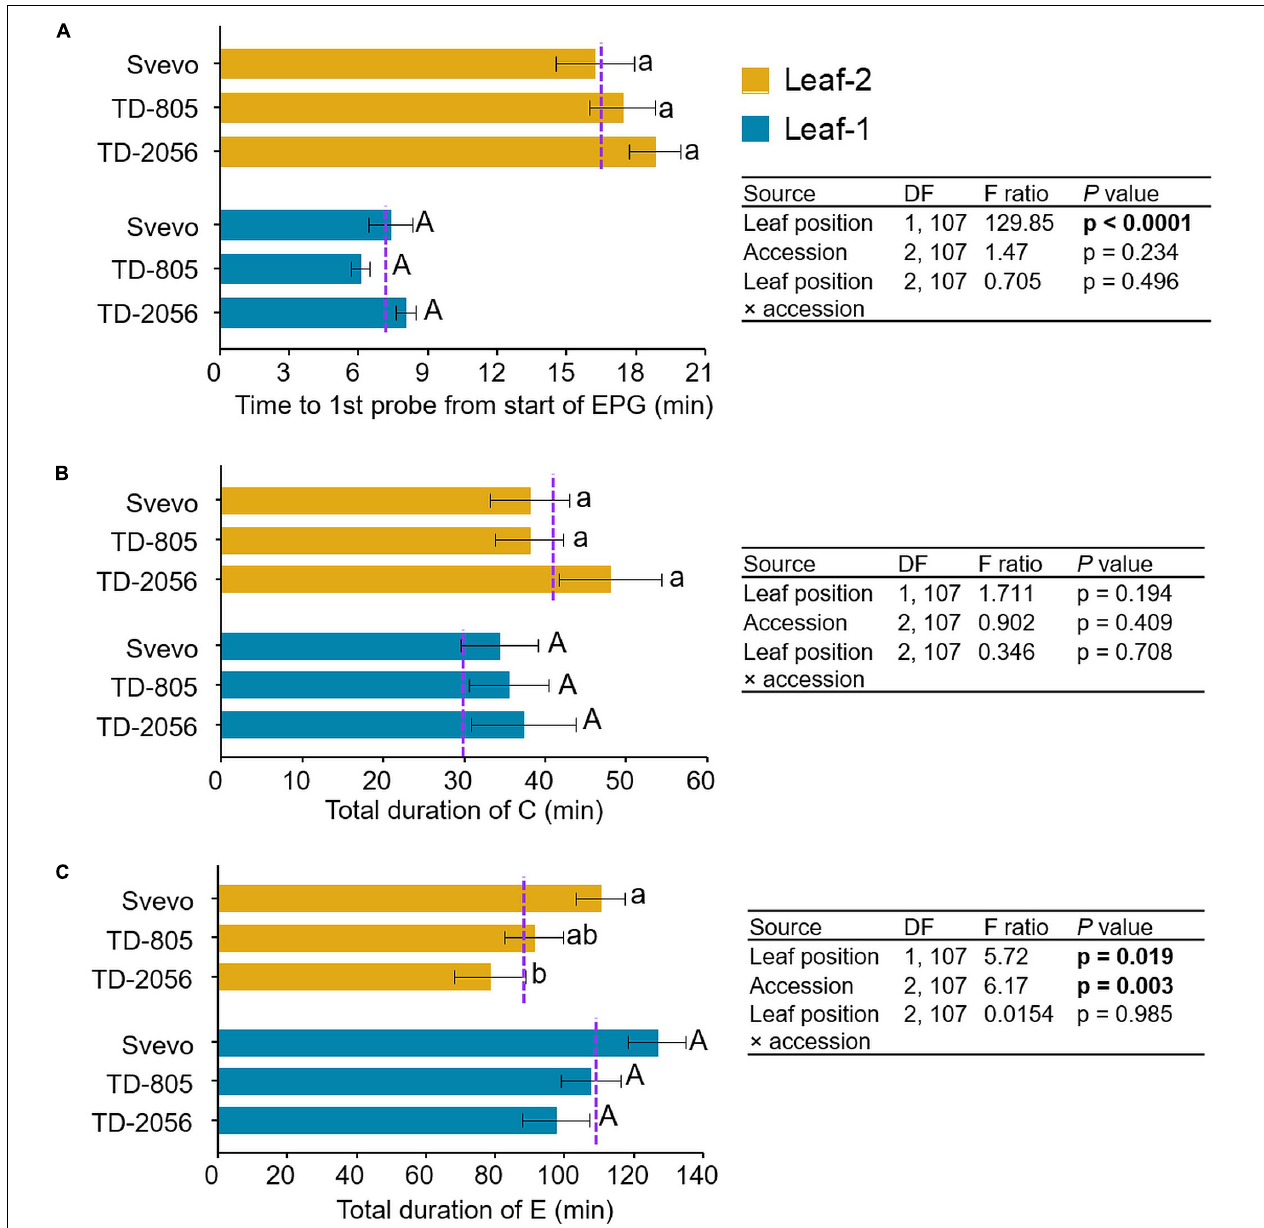
FIGURE 6 | Feeding behavior of R. padi aphids. Aphid feeding was measured on leaf-1 and leaf-2 of two selected wild emmer wheat (WEW) accessions and one domesticated durum wheat cultivar. Data of electrical penetration graph (EPG) waveforms were recorded in minutes. (A) time until first probe from the start of EPG, (B) total duration of C, and (C) total duration of E. Values are expressed as mean ± SE ( n = 18). The dotted purple line represents the overall mean value of the waveform on individual leaf types among the accessions. The effects of leaf position, accession, and their interaction (leaf position × accession) were tested by two-way ANOVA analyses. Significant differences between accessions are indicated by different letters (one-way ANOVA, Tukey’s honestly significant difference test, p < 0.05). In bold are the parameters that were significantly affected, p < 0.05.